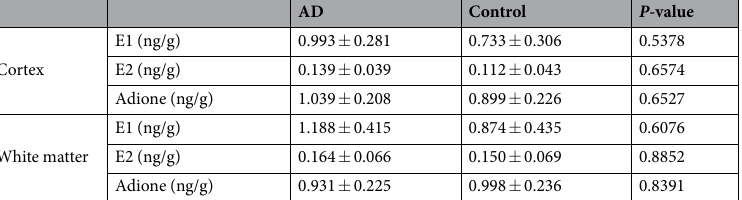
Table 1. Comparison of concentrations of sex steroid hormones in the cortex and white matter of the frontal lobe between Alzheimer’s disease and control groups. AD, Alzheimer’s disease; E1, estrone; E2, estradiol; Adione,